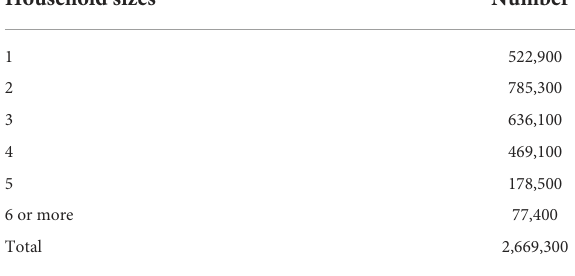
TABLE 3 Household sizes and